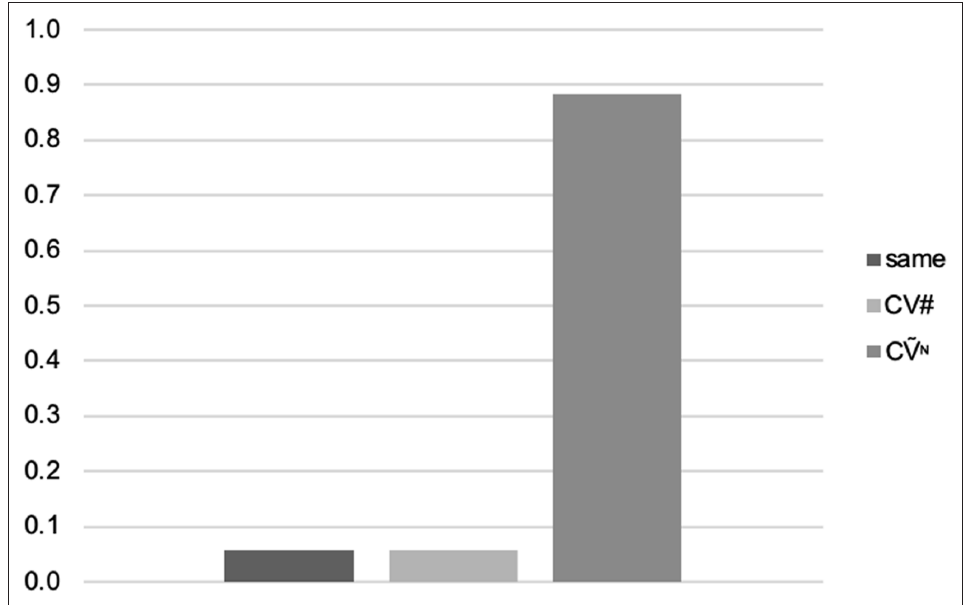
Figure 5: Rating responses for stimulus pair type